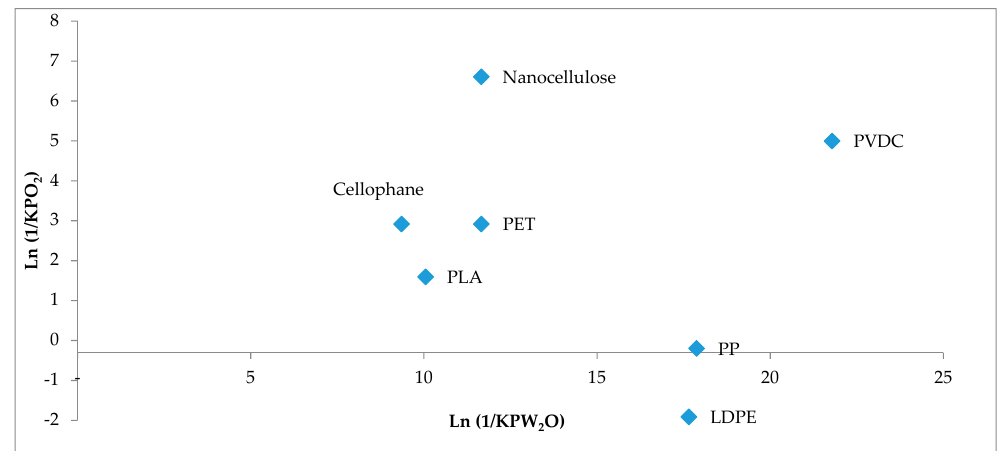
Figure 3. Oxygen and water vapor resistance coefficients of the nanocellulose in comparison with synthetic, bioplastics, and bio-based structures with KPO 2 and KPW 2 O expressed in cm 3 µmPa − 1 day − 1 m − 2 and cm 3 day − 1 m − 1 Pa − 1 , respectively (modified) [70].